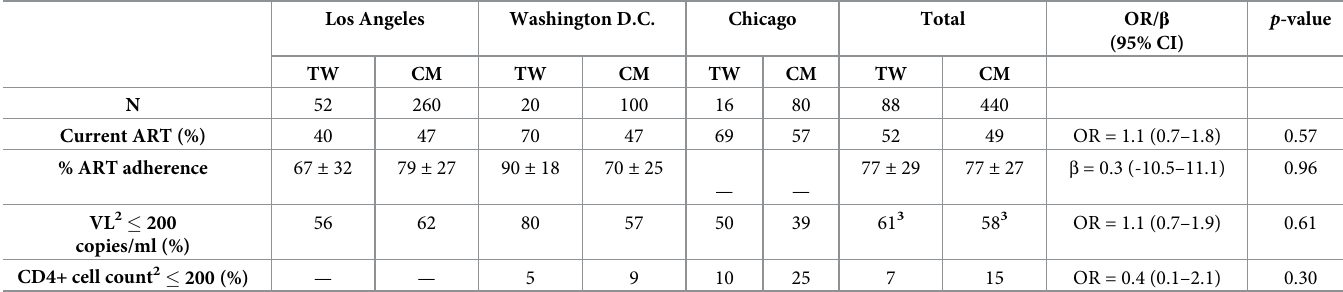
Table 5. HIV care continuum outcomes during reference period 1 , comparing transgender women and cisgender